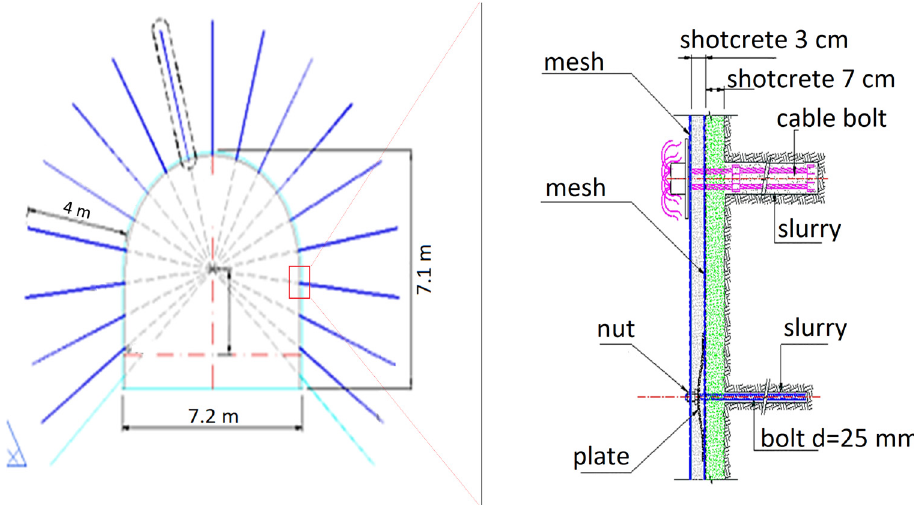
Figure 8. Example of support used in high seismic risk [52].